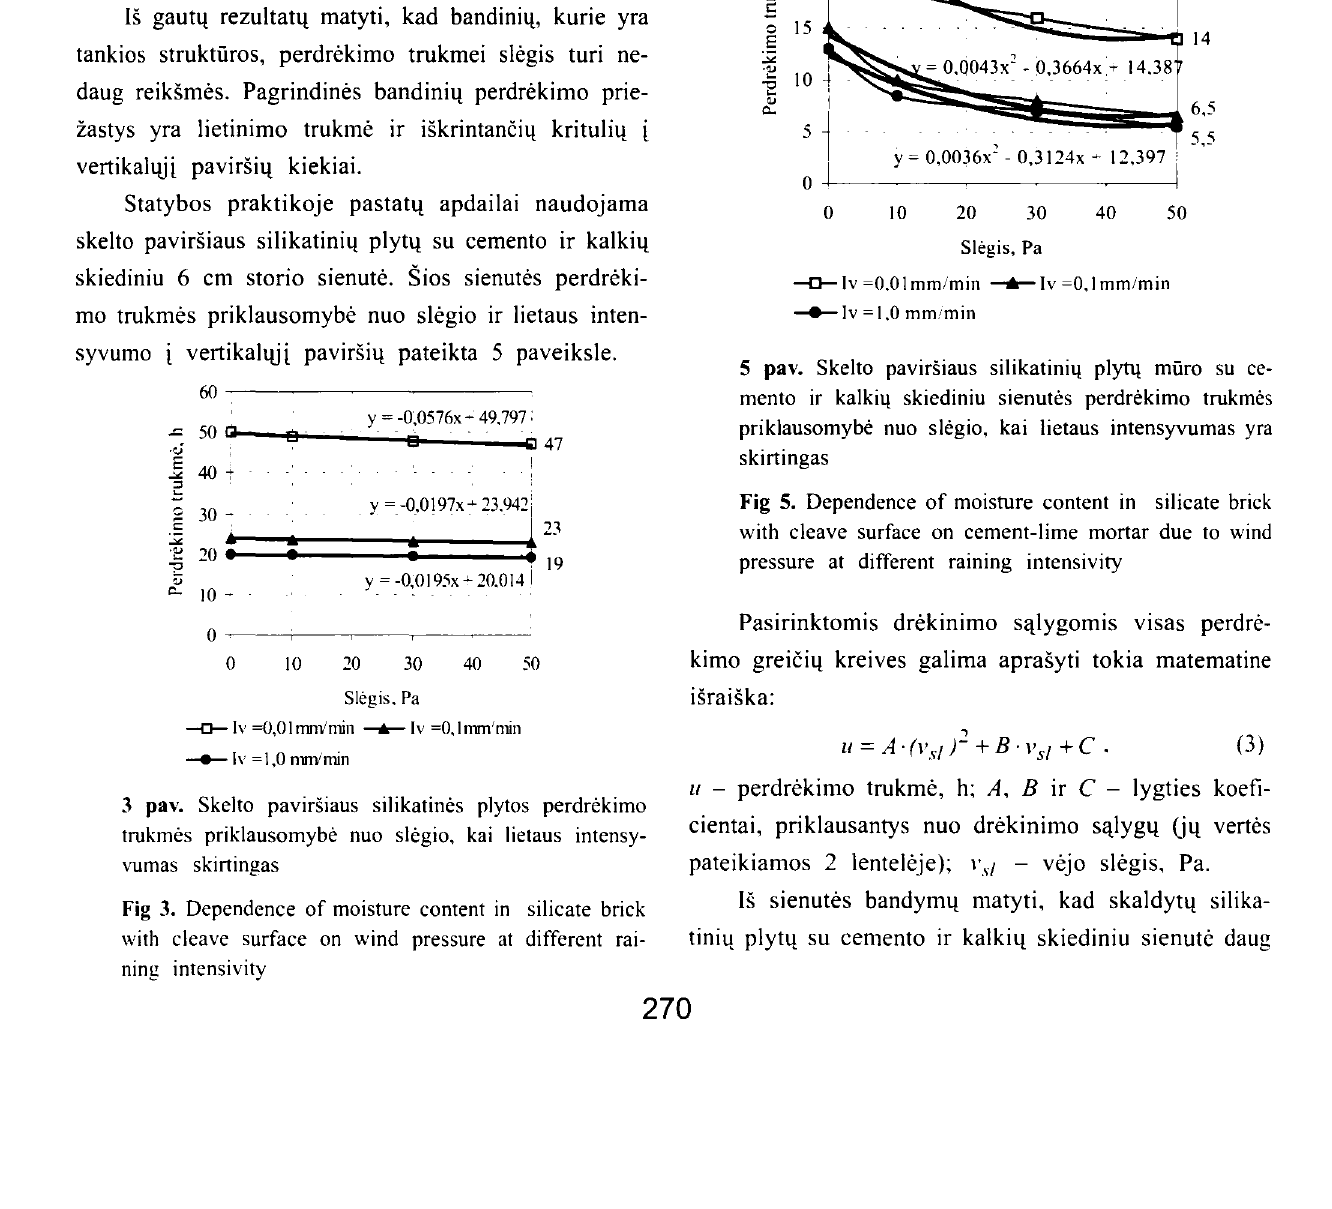
Fig 4. Dependence of moisture content in cement-lime mortar on wind pressure at different raining intensivity